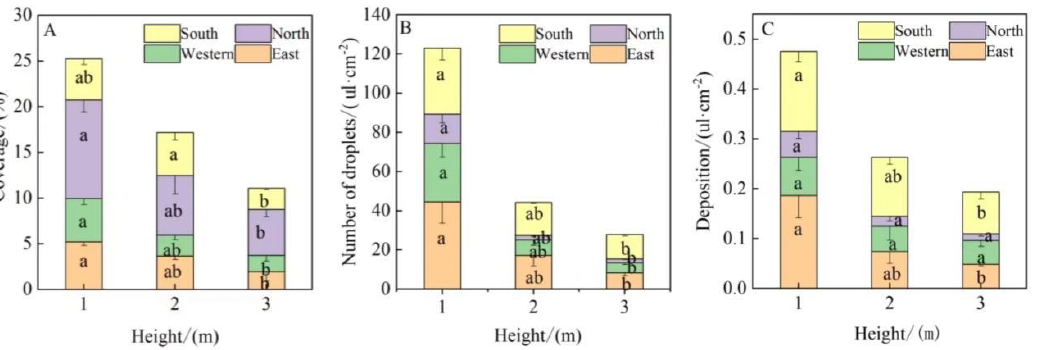
Figure 3. Comparison of canopy fog droplet effects of ‘Kuerle Xiangli’ treated at different heights: ( A ). comparison of the droplet coverage of ‘Kuerle Xiangli’ treated at different heights, ( B ). comparison of the droplet density of ‘Kuerle Xiangli’ treated at different heights, ( C ). comparison of the amount of droplet deposition of ‘Korla Fragrant Pear’ treated at different heights. The data are presented as mean ± standard error. Different lowercase letters indicate significant difference in the same direction among different treatments ( p < 0.05).